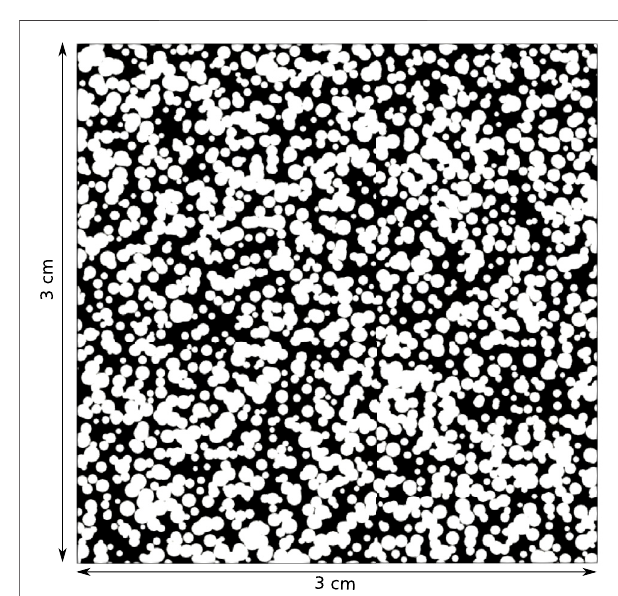
FIGURE 3 | Micromodel geometry for Benchmark